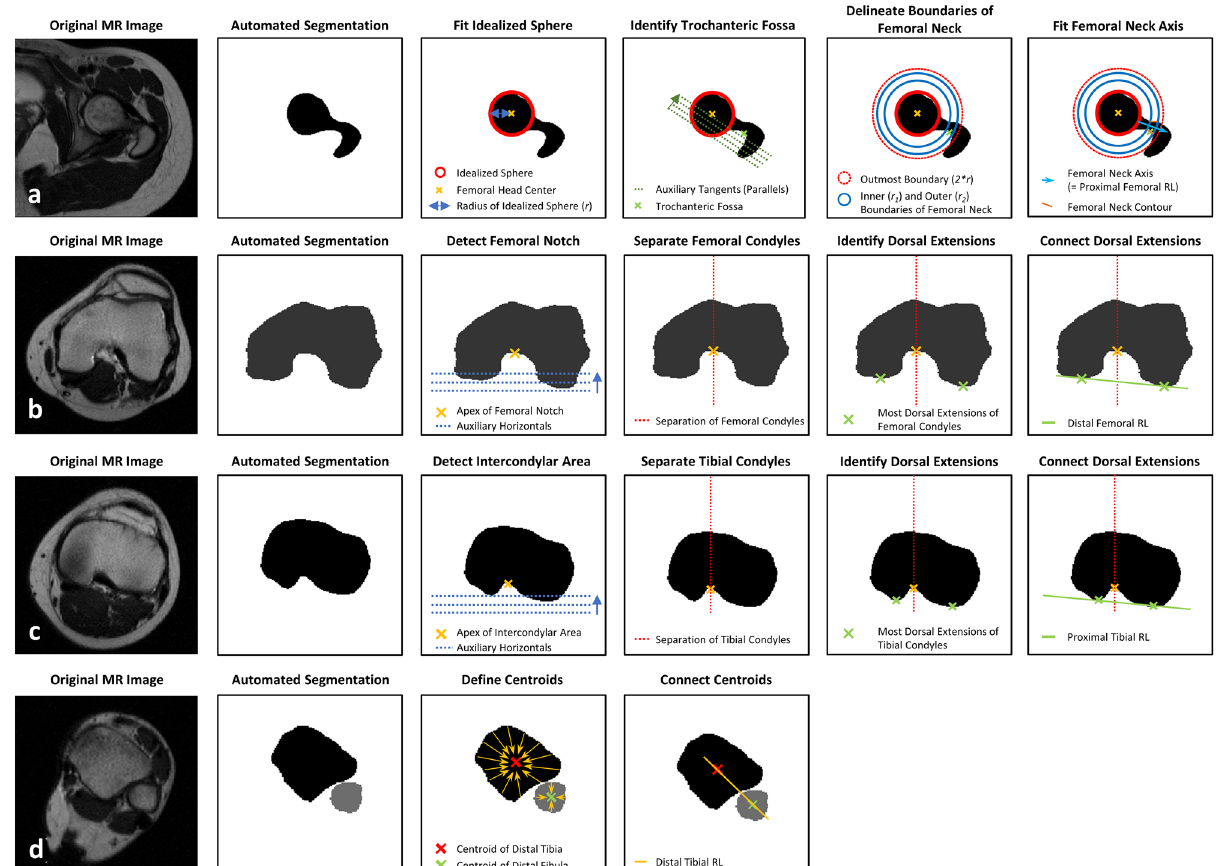
Figure 4. Algorithm-based identification of proximal and distal femoral and tibial reference lines to determine lower limb torsion. ( a ) At the hip, the femoral head centre was identified and used to define the femoral neck axis that served as the proximal femoral reference line. ( b , c ) Around the knee, the most posterior extensions of the medial and lateral femoral and tibial condyles were identified and connected as the distal femoral ( b ) and proximal tibial reference lines ( c ). ( d ) At the ankle, the tibial and fibular centroids were connected as the distal tibial reference line. RL reference line. MR images are not to